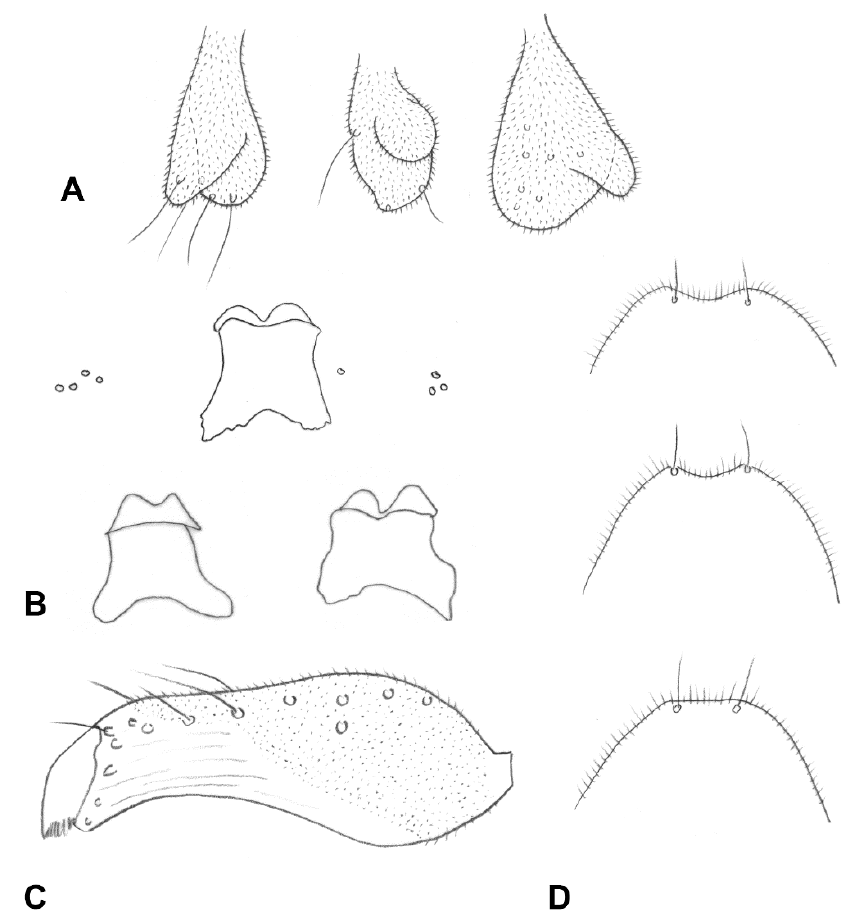
Figure 11. Ruschiola cedarbergensis . ( A ) Variation in palpus morphology. ( B ) Variation in spatula shape and associated papillae. ( C ) Male gonostylus, dorsal. ( D ) Variation in shape of male hypo-